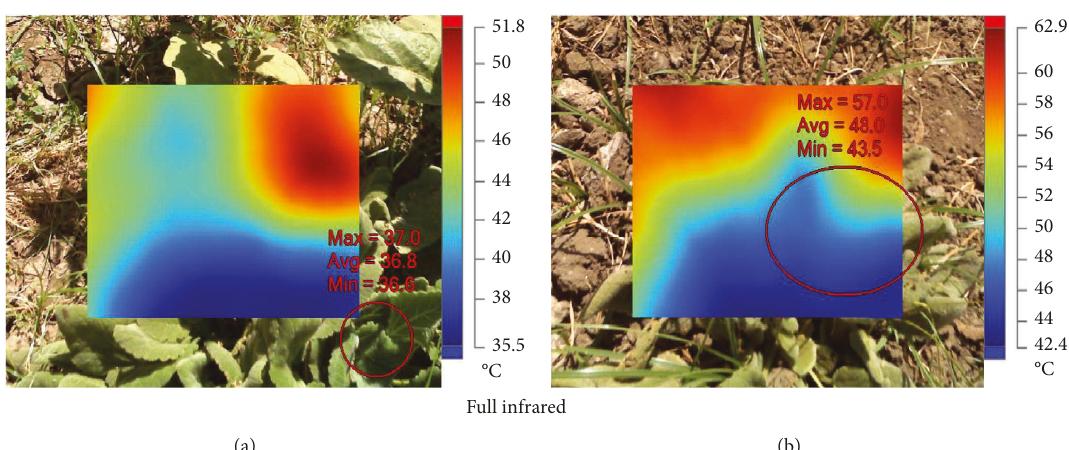
Figure 2: Canopy temperature (CT) of clary sage plants at 120 days after transplanting under full irrigation with 100% of reference crop evapotranspiration (ETo) (A) and water stressed at 50% of ETo (B) using full visible, full infrared, and blending level between full infrared and full